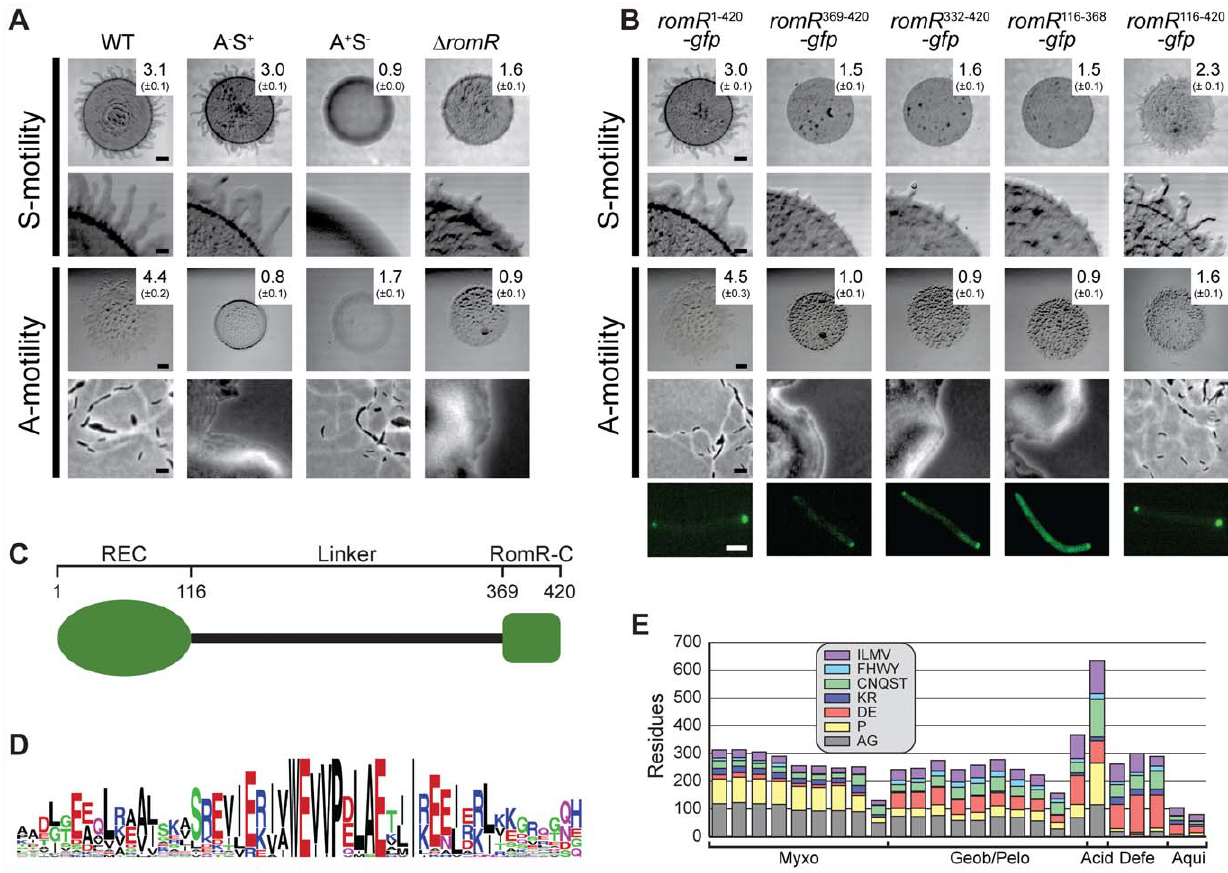
Figure 1. RomR is important for S- as well as for A-motility and contains two pole-targeting determinants. (A) RomR is important for S- as well as for A-motility. The indicated strains were incubated at 32 u C for 24 h on 0.5% agar/0.5% CTT medium to score S-motility and 1.5% agar/0.5% CTT medium to score A-motility. S-motility is evaluated by the increase in colony diameter at low magnification (upper row) together with a qualitative analysis of flairs at the colony edge at high magnification (lower row). A-motility is evaluated by the increase in colony diameter at low magnification (upper row) together with a qualitative analysis of single cells at the colony edge at high magnification (lower row). The numbers indicate the increase in colony diameter in mm 6 standard deviation after 24 h. Scale bars, 1 mm, 200 m m, 1 mm, and 5 m m from top to bottom row. (B) RomR-C and the linker region are independent pole-targeting determinants and both are required for motility. The top four rows are as described in panel (A). For the experiments in the fifth row, D romR cells expressing the indicated GFP fusions were transferred from liquid cultures to an agar pad on a slide and imaged by fluorescence microscopy. Scale bar, 2 m m. (C) RomR is composed of three distinct regions: a N-terminal response regulator receiver domain (REC), a conserved C-terminal region unique to RomR (RomR-C), and an unstructured linker region (Linker). Numbers correspond the RomR amino acid sequence from M. xanthus . (D) RomR-C is enriched in conserved Glu residues in addition to containing invariant Trp and Pro residues. The sequence logo of RomR-C was built using WebLogo ([67]. (E) The RomR linker displays length and composition in relation to taxonomy. The graph shows the amino acid composition of the linker regions of sequences from Myxococcales (Myxo), Geobacter and Pelobacter species (Geob/Pelo), Acidobacteria (Acid), Deferribacterales (Defe), and Aquificales (Aqui). The amino acids were grouped based on physicochemical properties. Sequences lacking RomR-C were not included in the analysis.